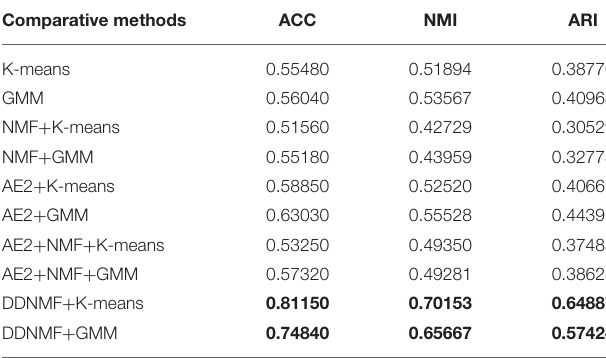
TABLE 1 | The experimental results on MNIST.